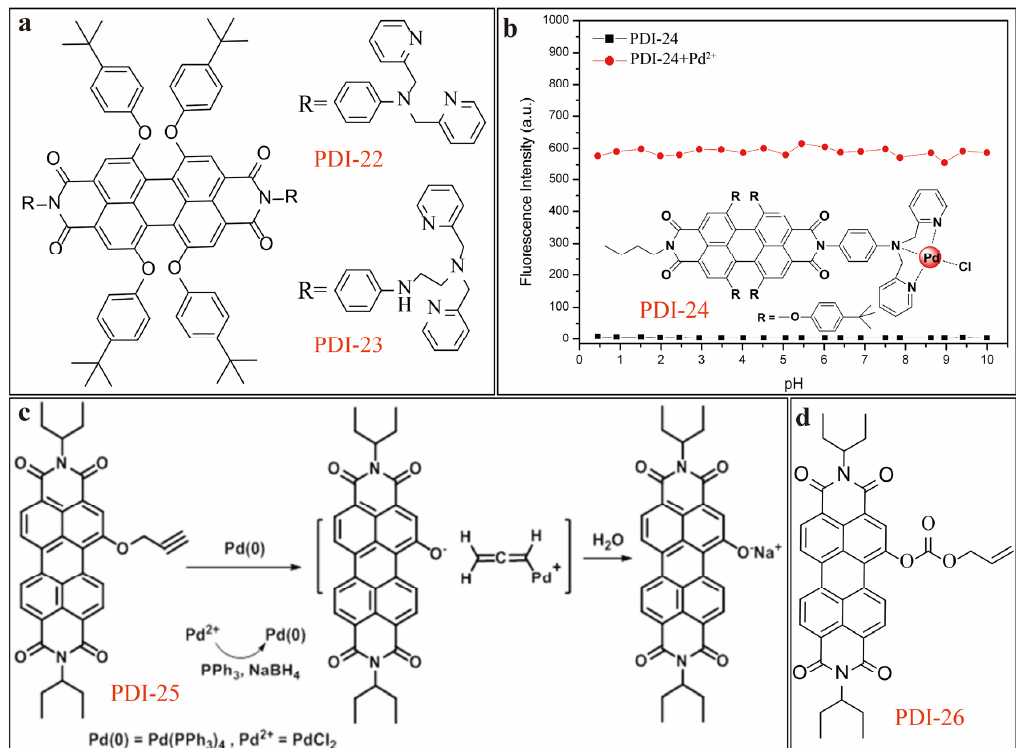
Figure 8. ( a ) Molecular structures of PDI-22 and PDI-23. ( b ) pH-resistant fluorescence intensity of PDI-24 (5 µM) in DMF/H 2 O (7:1, v/v) before and after binding with Pd 2+ under excitation